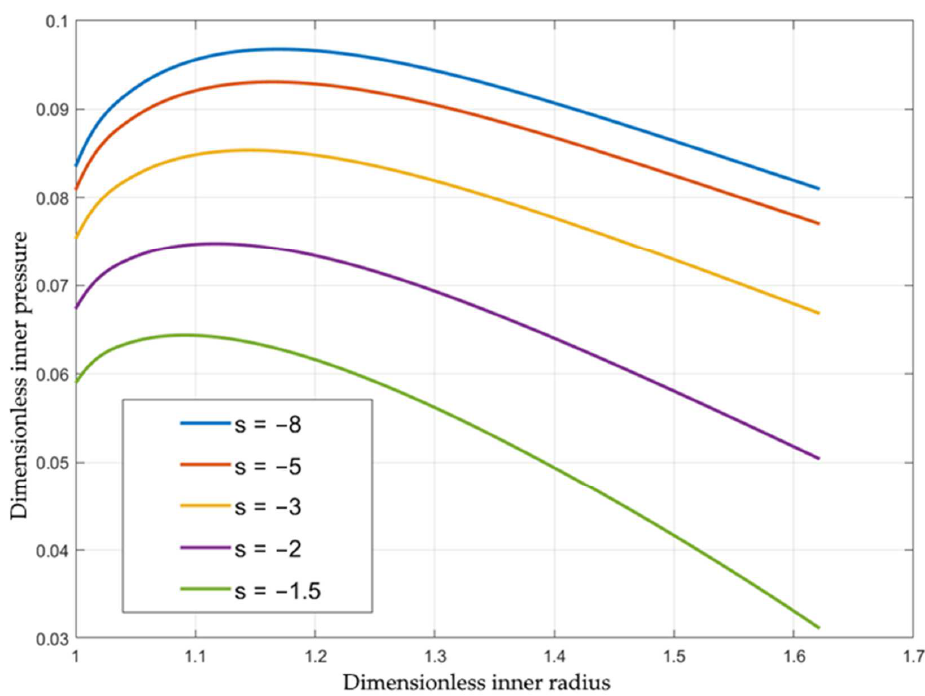
) [22], and SS-304 steel ( [23]. Surprisingly, the most significant difference occurs in the case of two functions for SS-304 provided in two different sources. The reason for this difference in the present so- lution is that the stress–strain curves are very different. Figure 2. Variation of the inner pressure with the inner radius for several loading paths.